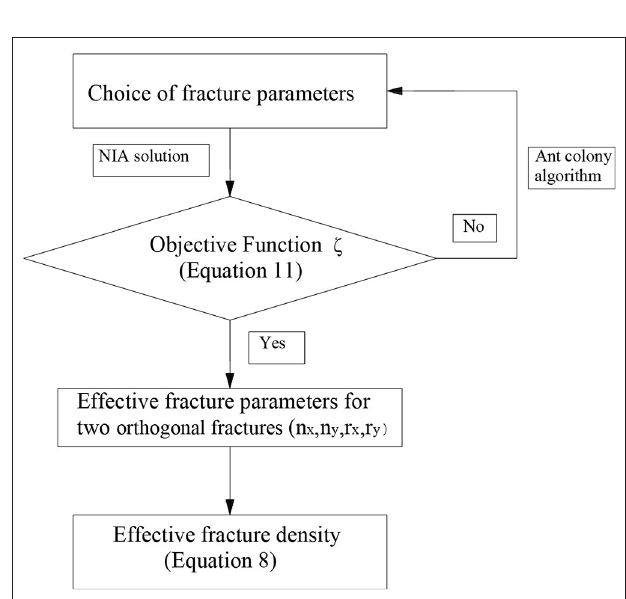
FIGURE 10 | A workflow chart to describe the inversion